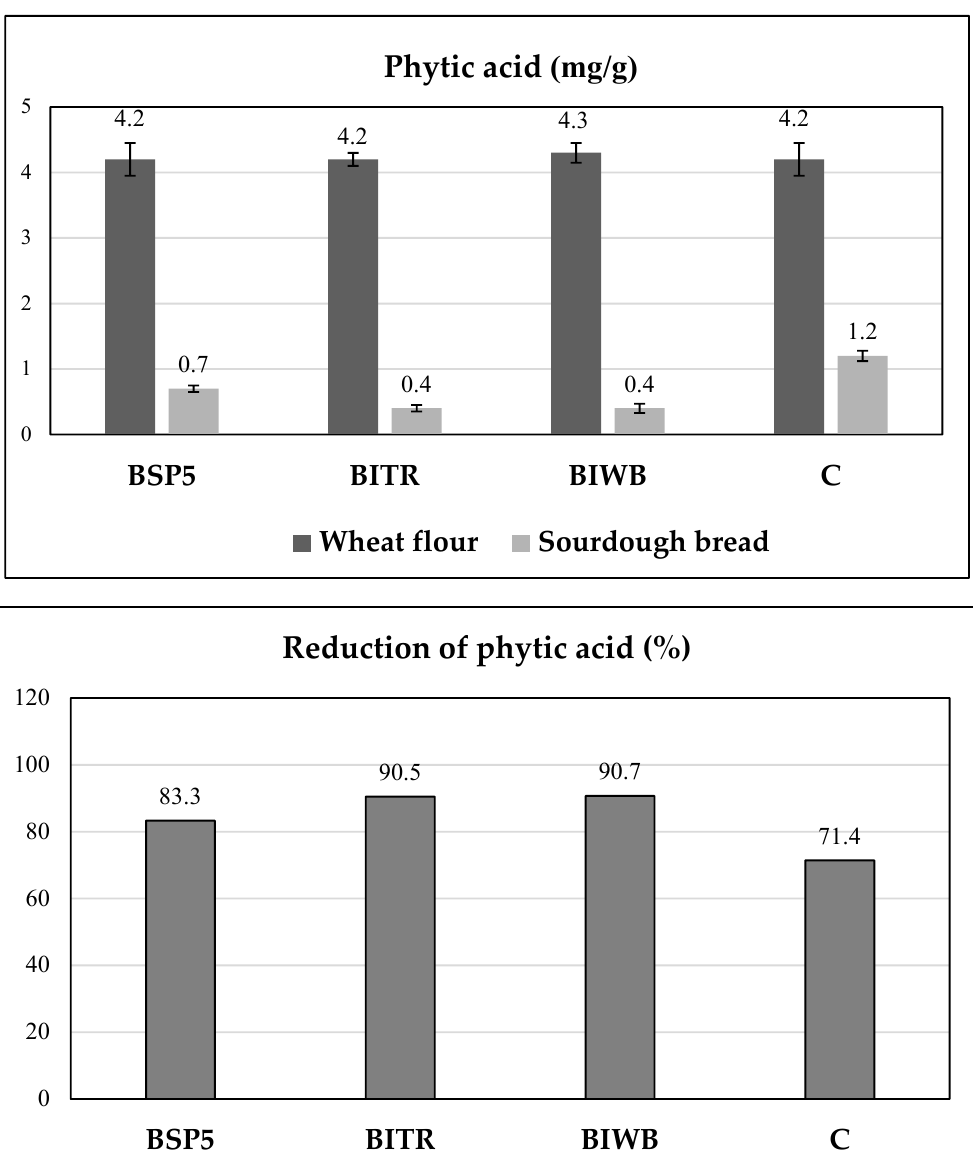
Figure 2. Phytic acid content (up) and phytic acid reduction (down) in doughs before and after baking (BSP5: bread made with sourdough containing free, freeze-dried L. paracasei SP5 cells; BITR: bread made with sourdough containing ITR; BIWB: bread made with sourdough containing IWB; CB: control bread made with wild microflora